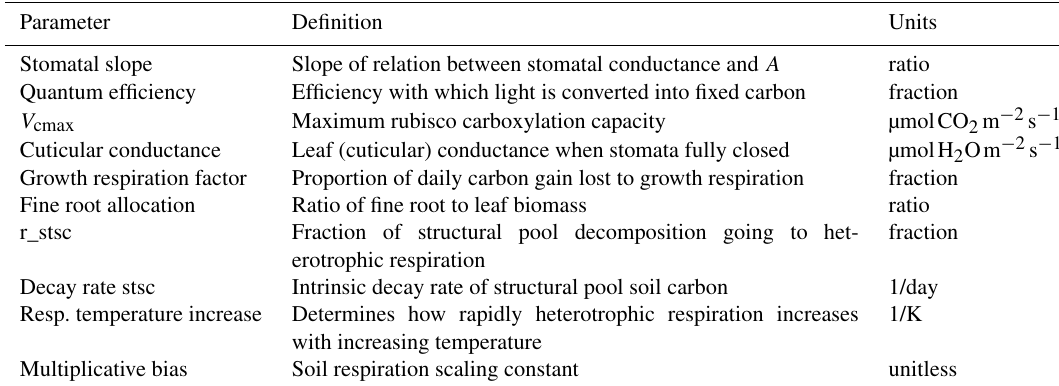
Table A4. Calibrated ED2